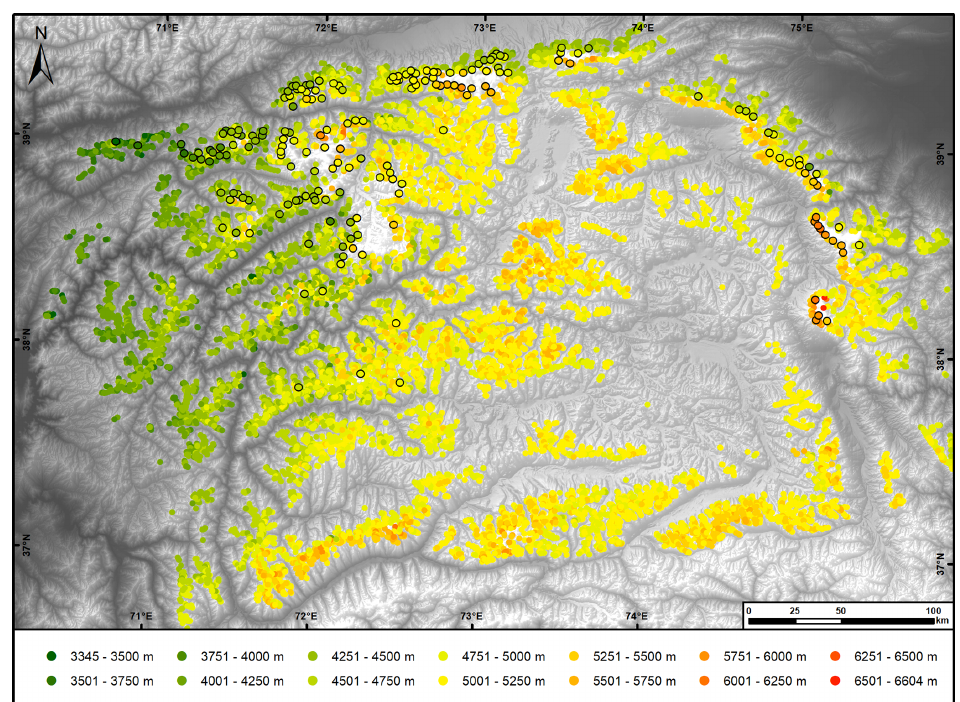
Figure 10. Colour-coded median elevation map with surging glaciers marked (discs with outlines). DEM source: AW3D30.